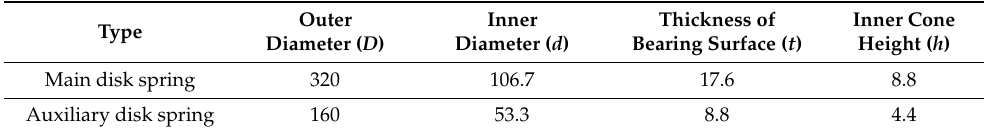
Table 1. Geometrical parameters of the coned disk spring. Outer Type Diameter ( D